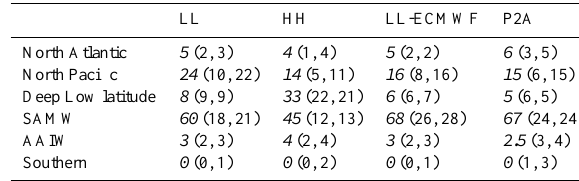
Fig. 7. Zonal and depth-average δ 14 C above (a) and below (b) the 27.4 isopycnal for the observations from the GLODAP database (Key et al., 2004) and 3 of the 4 ocean models described in Ta- ble 1. The LL-ECMWF model is excluded, because it was not run with δ 14 C as a tracer.